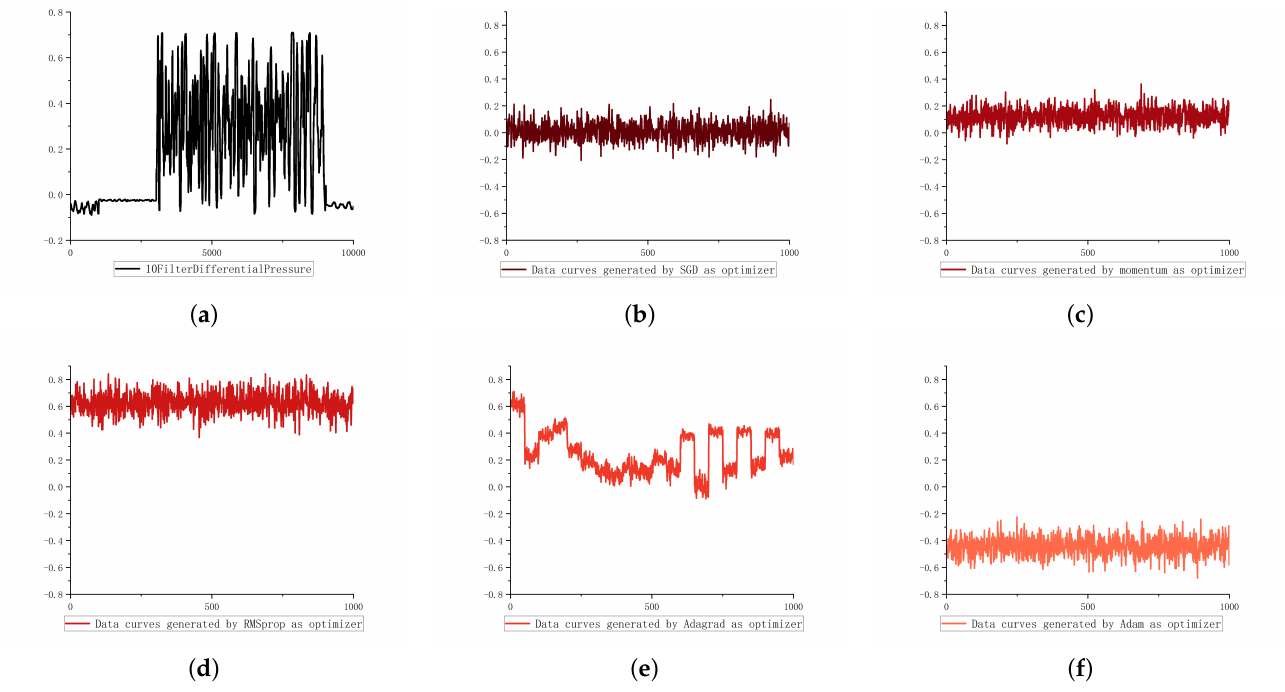
Figure 4. ( a ) Original data of 10 filter differential pressure features of the real underlying business dataset of the oil depot; ( b ) SGD is selected as the generation result of the optimizer; ( c ) momentum is selected as the generation result of the optimizer; ( d ) RMSprop is selected as the generation result of the optimizer; ( e ) Adagrad is selected as the generation result of the optimizer; ( f ) Adam is selected as the generation result of the